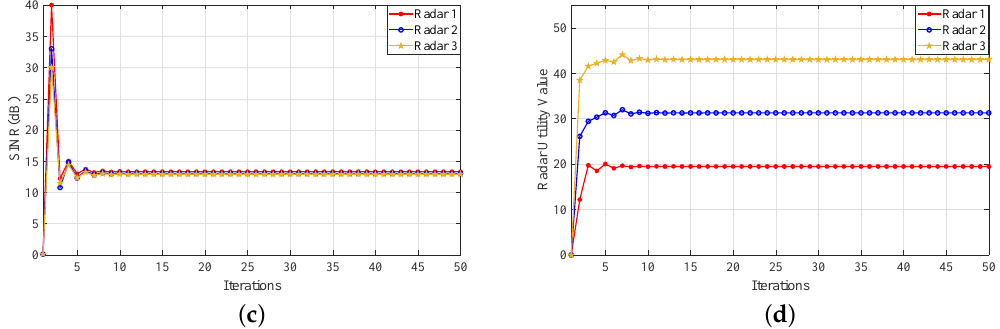
Figure 5. Stackelberg PAG Algorithm 2. ( a ) Power allocation convergence for multistatic MIMO radar. ( b ) Power allocation convergence for BS. ( c ) SINR convergence for multistatic MIMO radar. ( d ) Utility value convergence for multistatic MIMO